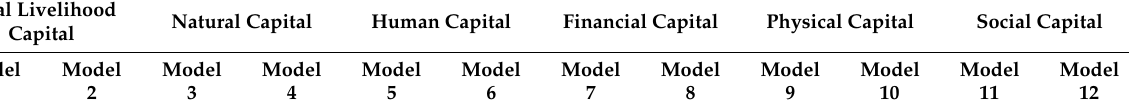
Table 4. The dynamics regression model result of the impact of the fiscal expenditure scale on livelihood